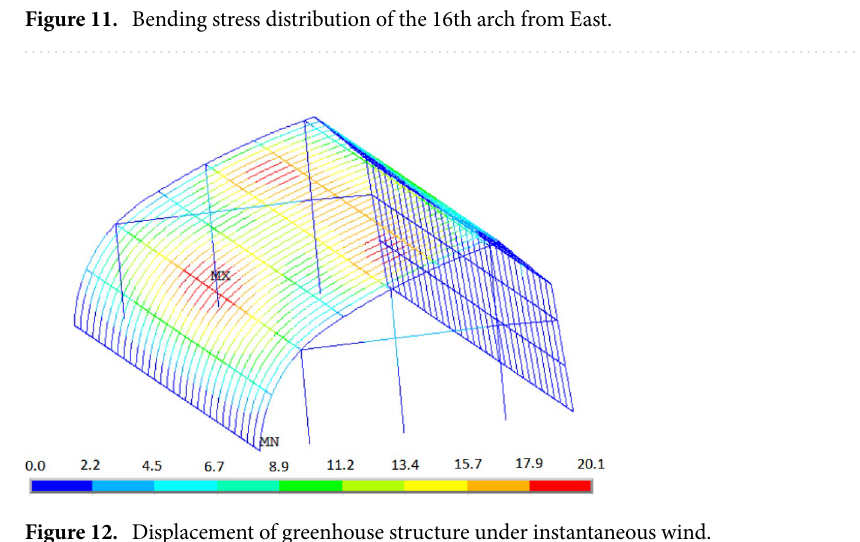
Figure 12. Displacement of greenhouse structure under instantaneous